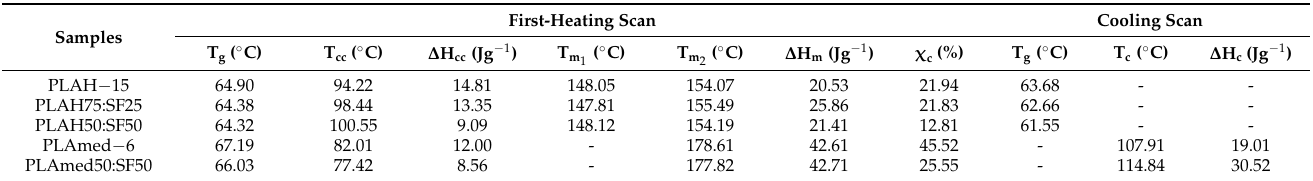
Table 6. Thermal properties of PLAH − 15, PLAH75:SF25, PLAH50:SF50, PLAmed − 6, and